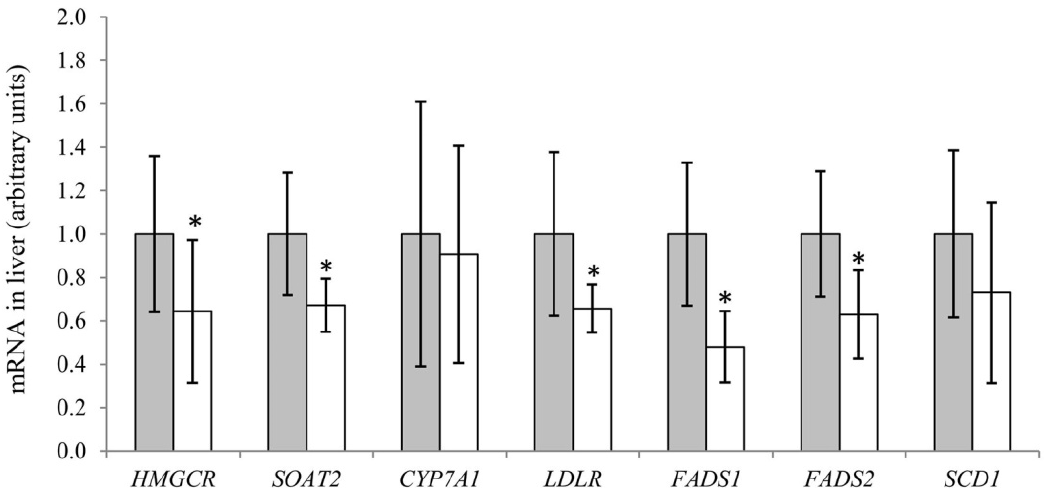
Figure 1. Hepatic mRNA levels in obese Zucker fa/fa rats fed Control Diet (grey bars) or Baked Cod Diet (white bars), presented relative to 18S rRNA and normalised to Control group. Values are mean and standard deviations, n = 9 in Zucker fa/fa Control Group, and n = 10 in Baked Cod Group. * Significantly different from rats fed Control Diet. p < 0.05 were considered statistically significant. Groups are compared using Independent Samples t-test assuming equal variances. HMGCR; HMG-CoA reductase, SOAT2; Sterol O-acyltransferase 2, CYP7A1; Cholesterol 7 alpha-hydroxylase, LDLR; Low density lipoprotein receptor, FADS1; Fatty acid desaturase 1, FADS2; Fatty acid desaturase 2, SCD1; Stearoyl-CoA